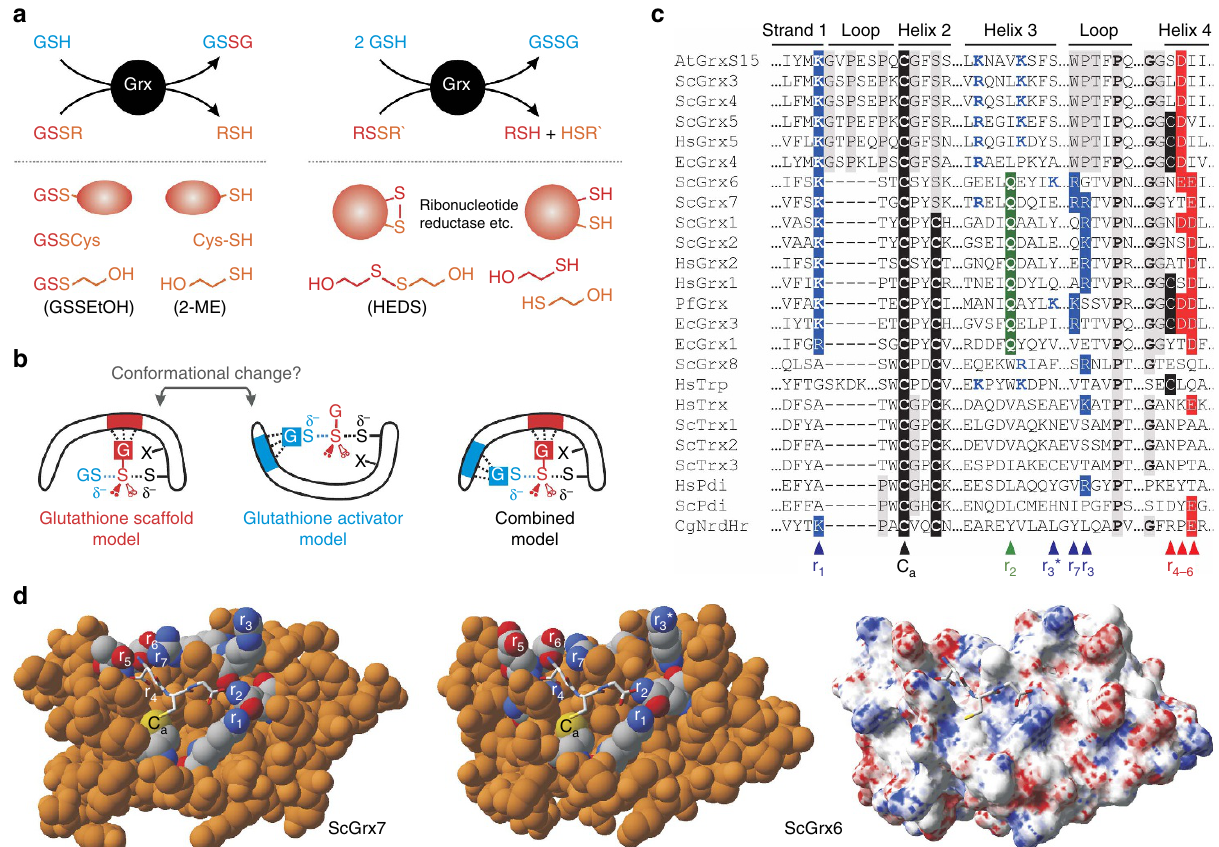
Figure 1 | Structure–function relationships of glutaredoxins. ( a ) Enzymatically active glutaredoxins (Grx) use GSH as an electron donor for the reduction of high- and low-molecular weight glutathione disulfide substrates (left side) or non-glutathione disulfide substrates (right side). ( b ) Two nonexclusive models for glutaredoxin catalysis are based on the reaction geometry of the transition states of thiol-disulfide exchange reactions. The models distinguish protein–substrate interactions with the glutathione moieties of GSSR in red and GSH in blue 3,12 . Only the transition state yielding GSSG is shown for the sake of simplicity. ( c ) Sequence alignment of glutaredoxin isoforms and comparison with other proteins of the thioredoxin superfamily from A. thaliana (At), S. cerevisiae (Sc), Homo sapiens (Hs), P. falciparum (Pf), E. coli (Ec) and C. glutamicum (Cg). The manual alignment is based on structural overlays and comparisons of PDB entries 2WCI, 3L4N, 3D4M, 3D5J, 2M80, 2WUL, 2WOU, 1MEK, 1B4Q and 4FIW. ( d ) Comparison between models of ScGrx7 and ScGrx6 with potential glutathione-interacting residues highlighted 11 . The structure of ScGrx6 was confirmed by Luo et al. (PDB entry 3L4N) 24 . The electrostatic potential was computed and mapped to the protein surface using the Poisson-Boltzmann method of Swiss-PDB Viewer at 0.1 M solvent ionic strength (colouring: red (cid:2) 4, blue þ 4). Orientation and numbering of potential glutathione-interacting residues r 1–7 in c and d are based on previous presentations 3,11 to facilitate a